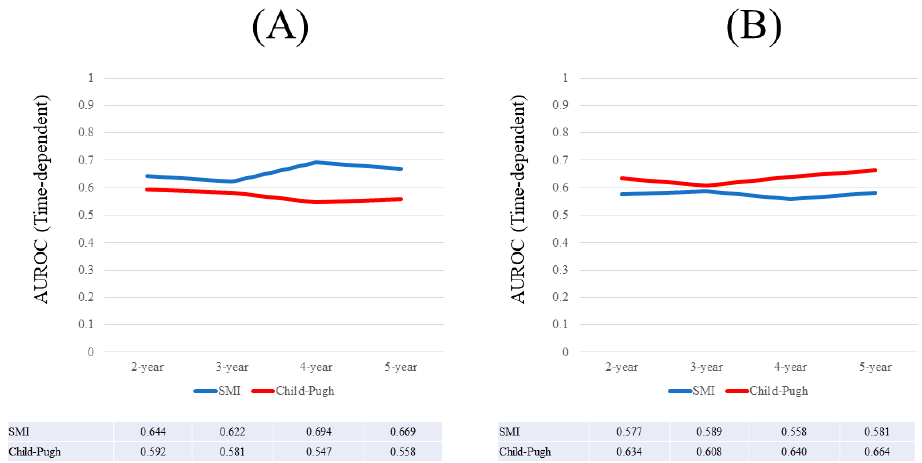
Figure 5. ( A ) Results for time-dependent ROC analyses at two-, three-, four-, and five-years of SMI and Child-Pugh scores for male Child-Pugh A patients; ( B ) Results for time-dependent ROC analyses at two-, three-, four-, and five-years of SMI and Child-Pugh scores for female Child-Pugh A patients. ROC; receiver operating characteristics, AUROC; area under the ROC, SMI; skeletal muscle mass